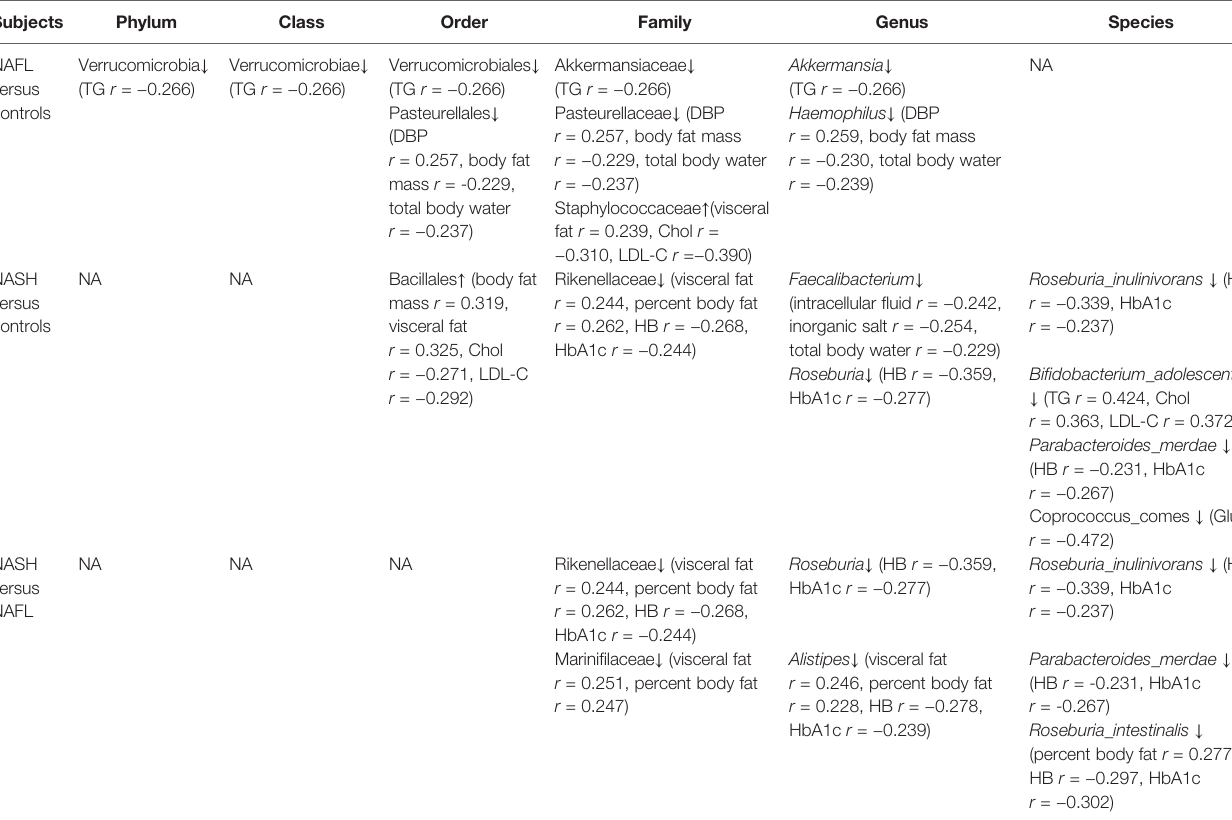
TABLE 3 | Correlation between the glucose, lipid, and water-electrolyte metabolism data and gut microbiota in different groups. Subjects Phylum Class Order NAFL Verrucomicrobia ↓ versus (TG r = − 0.266) controls